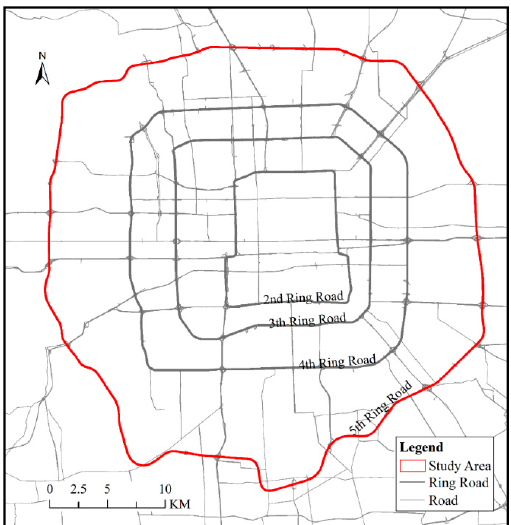
Figure 1. Study area.